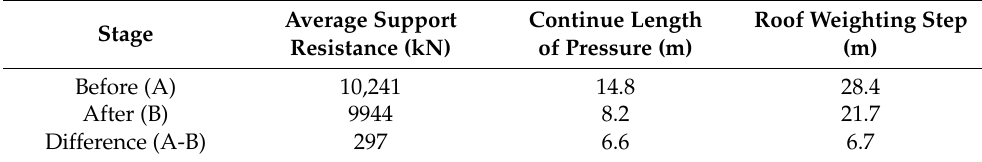
Table 5. Comparison of pressure characteristics before and after pre-split